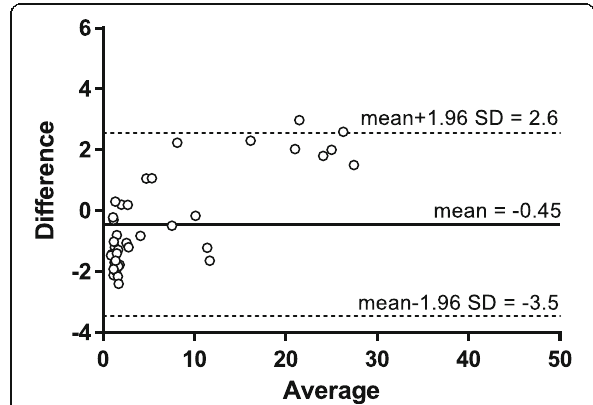
Fig. 4 Bland-Altman plot of the difference between the new method and ELISA vs. the average of the two methods. The continuous line represents the mean of the differences between the two methods while the dotted lines represent the limits of agreement from − 1.96 SD to + 1.96 SD